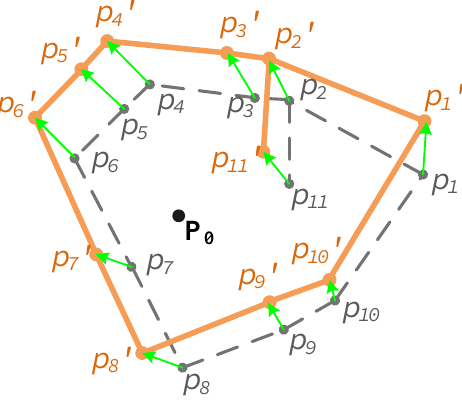
Figure 5. Local distortion map based on mesh partition. Orange solid lines: initial NAVTEQ; grey dash lines: distorted NAVTEQ; green arrows: linkages.